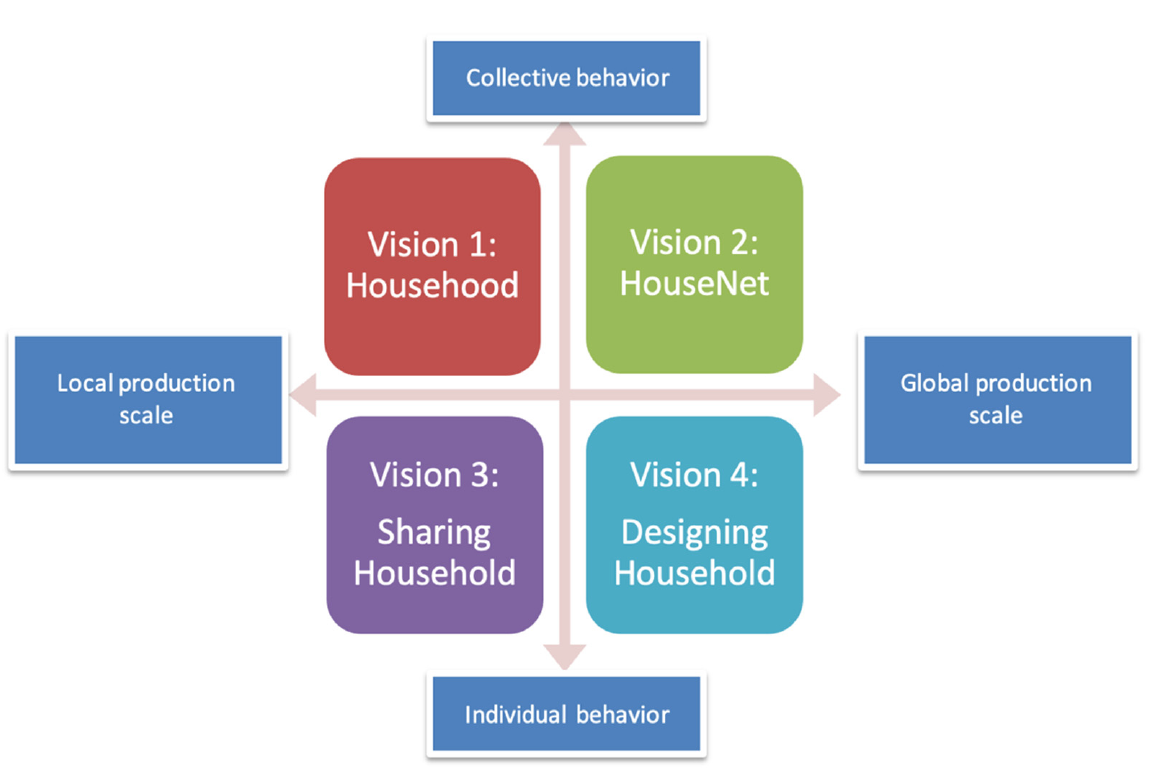
Figure 5. Four visions of future circular households mapped along two axes: production scale (from local to global) and behavior (from individual to collective).